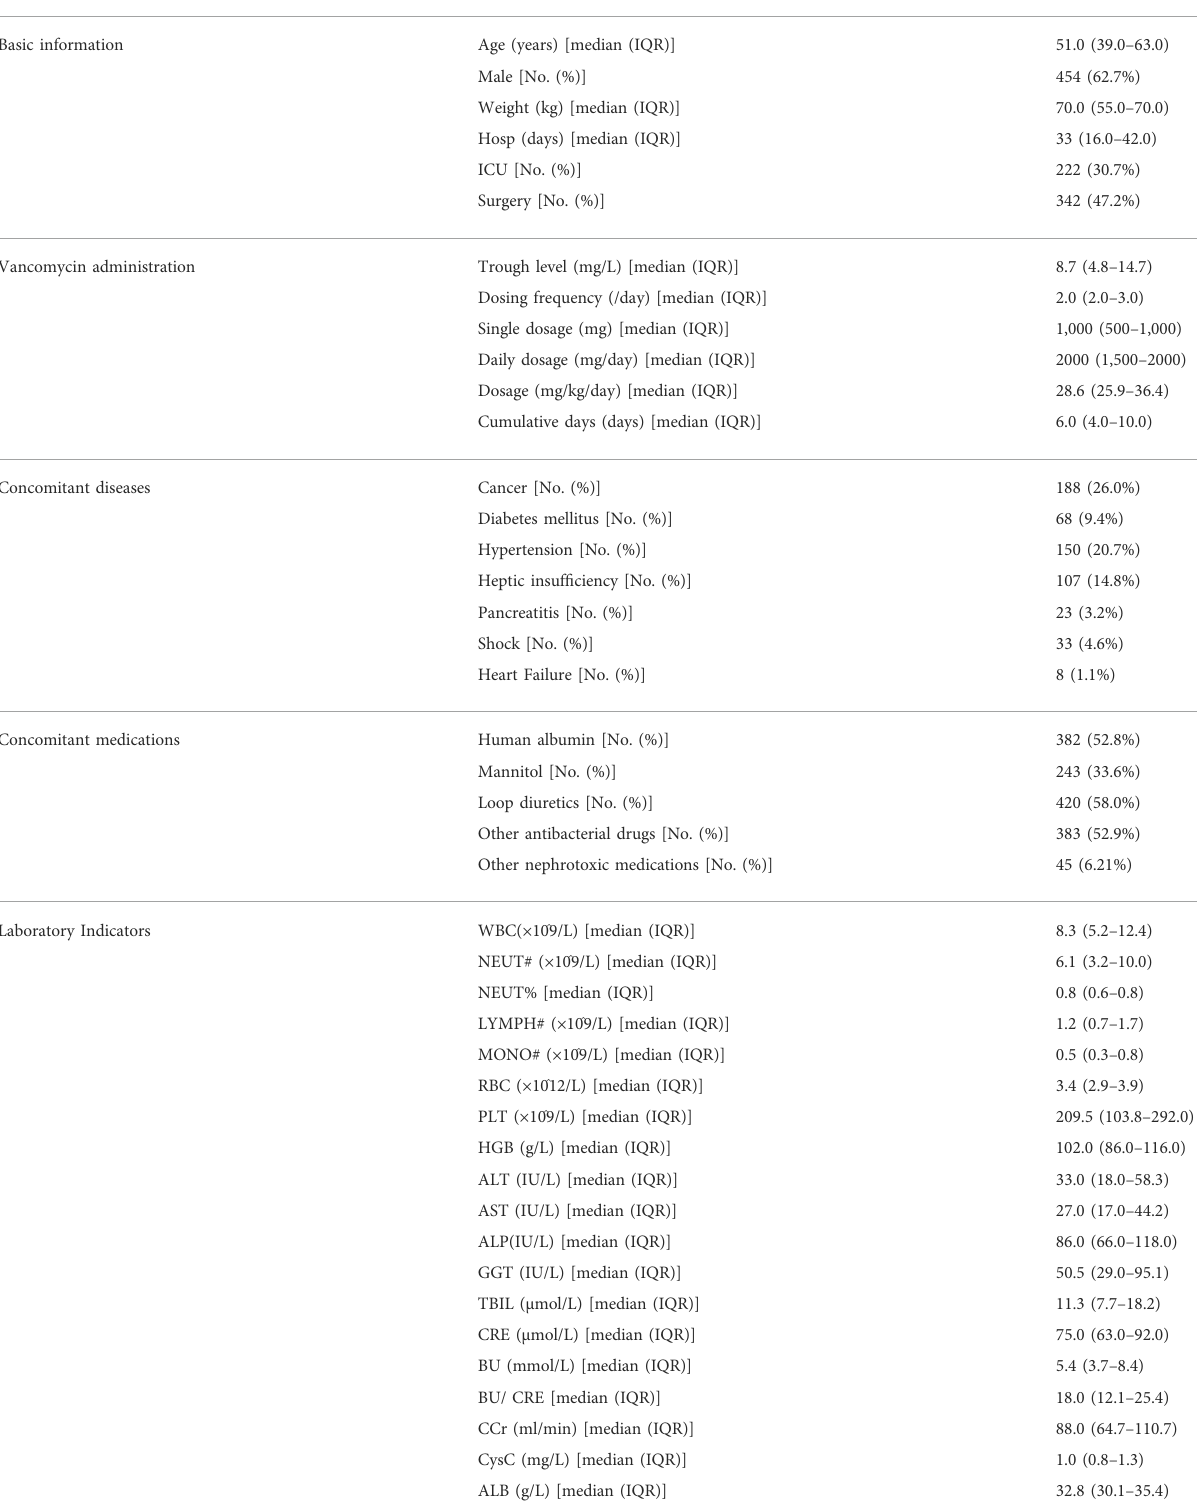
TABLE 1 Characteristics of patients at baseline and clinical